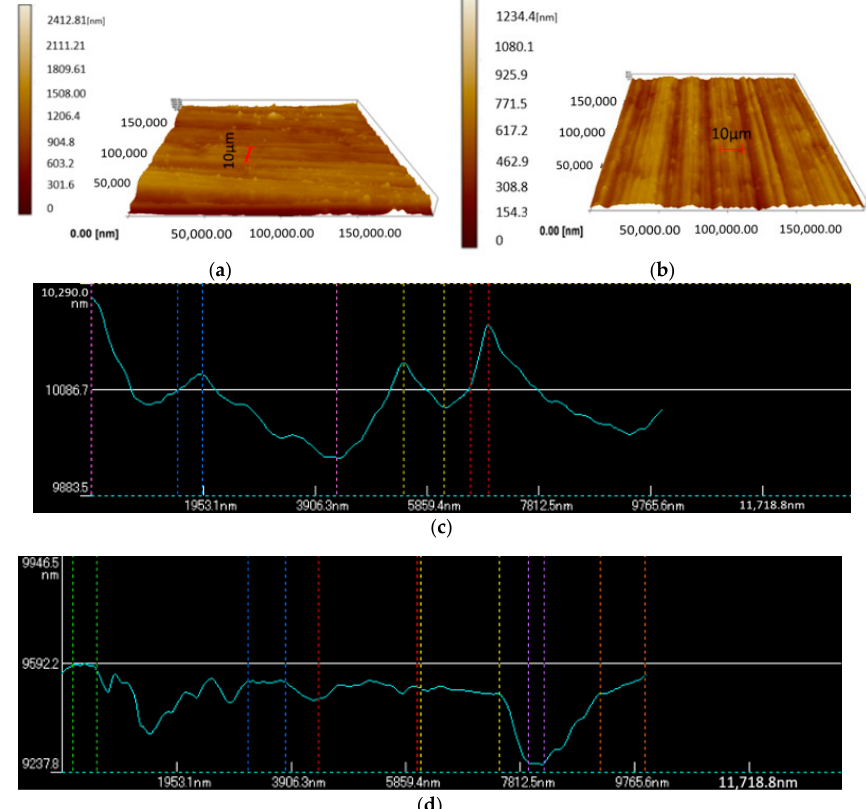
Figure 9. The 2D profile extracted from the 3D area. Topography of the sample at a ( a ) 0.5 μ m amplitude and ( b ) 6 μ m amplitude. The 2D profile of the sample at a ( c ) 0.5 μ m amplitude and ( d ) 6 μ m amplitude.